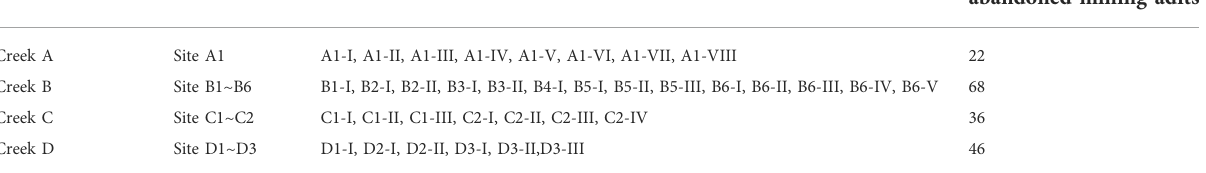
TABLE 1 Number of waste rock heaps and abandoned mine adits in the abandoned pyrite mining